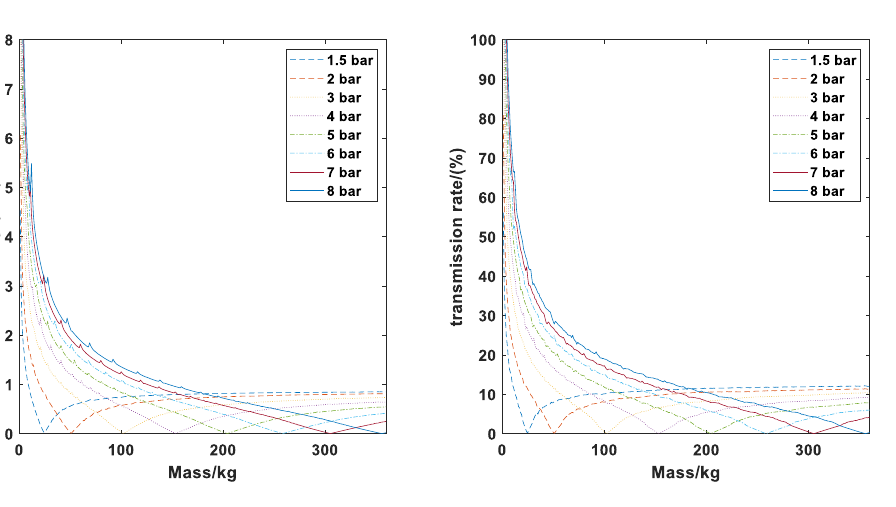
Figure 12. Mass effect simulation under 100 Hz vibration.